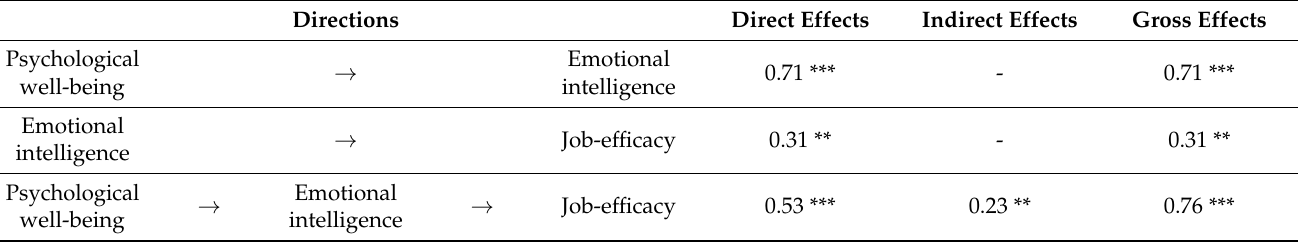
Table 7. Mediated effect